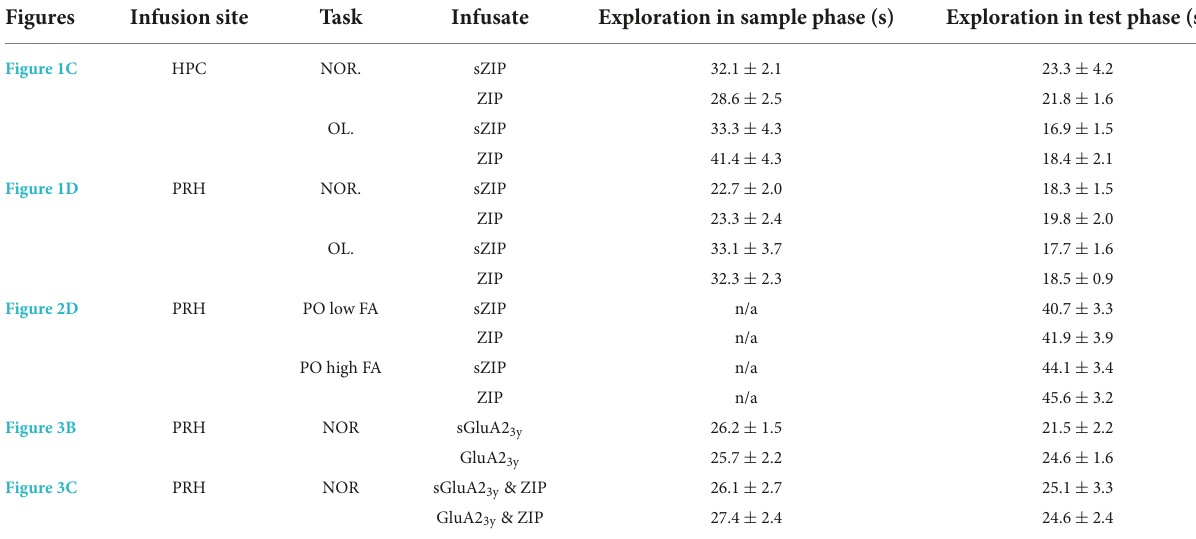
TABLE 1 Mean exploration times in the sample and test phases across all three tasks